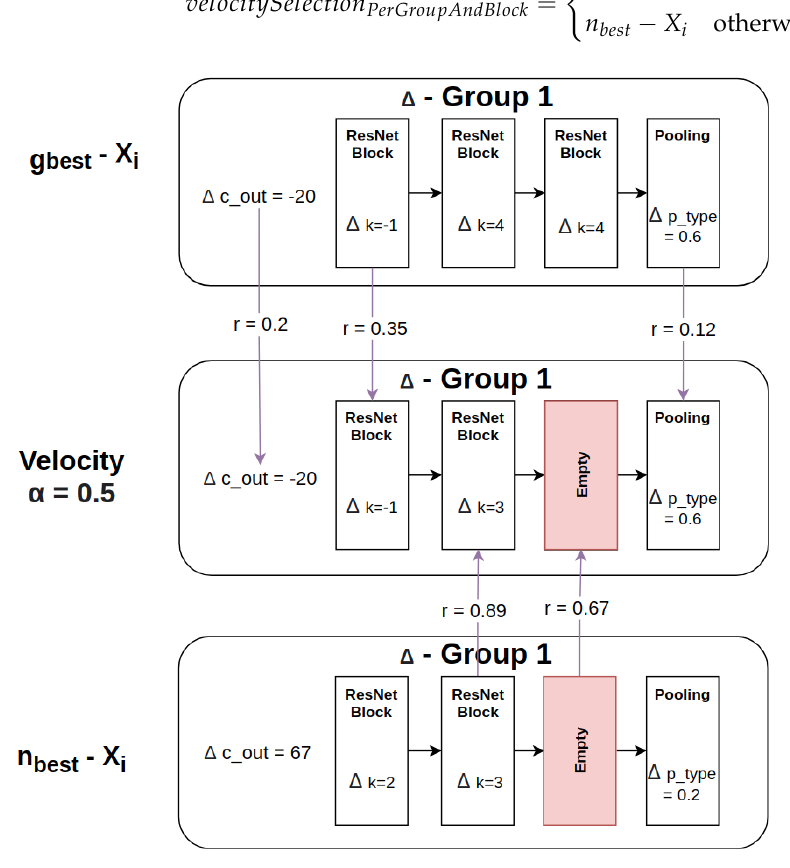
Figure 6. An example of velocity calculation between the selection of n best − X i and g best − X i